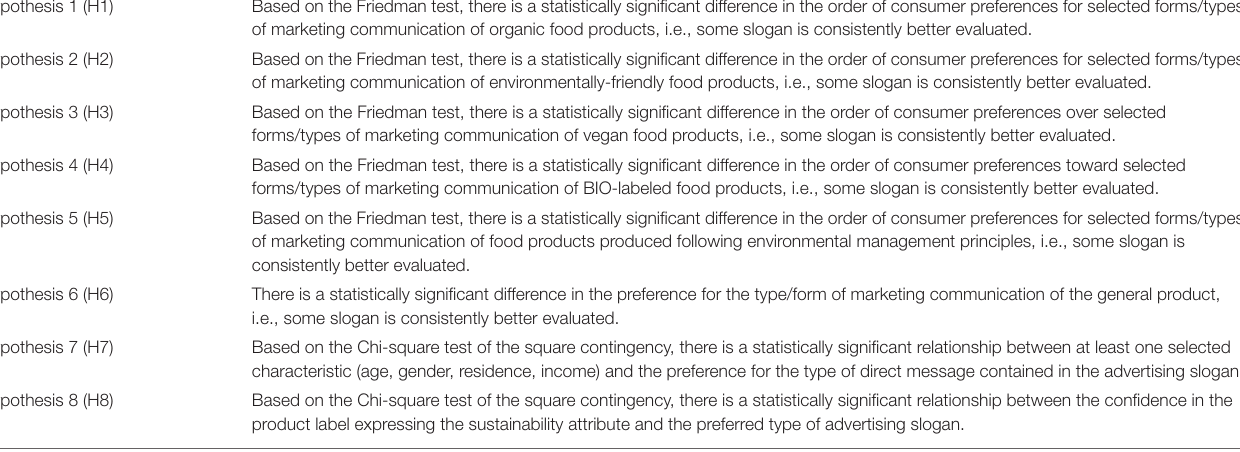
TABLE 1 | Research hypotheses; Source: own processing. Hypothesis 1 (H1)